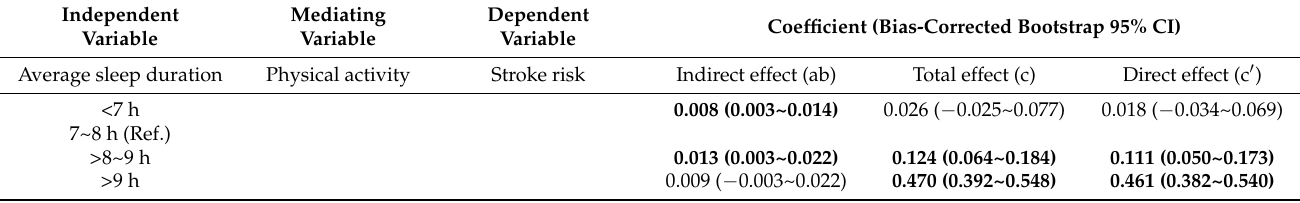
Table 5. Summary of the mediation analysis for average sleep duration, physical activity, and stroke